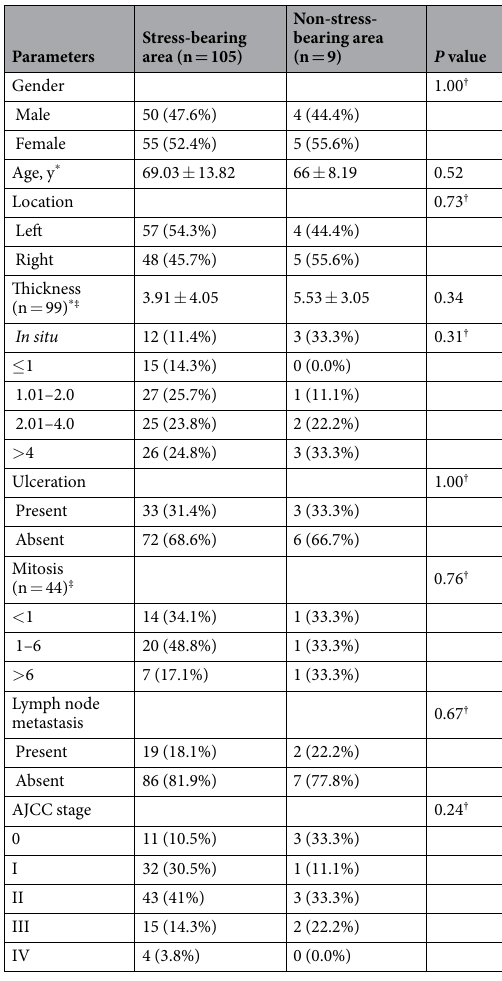
Table 1. Factors associated with the stress- and non-stress-bearing areas. * Mean ± standard deviation. † Use Fisher exact test. ‡ Available data only.